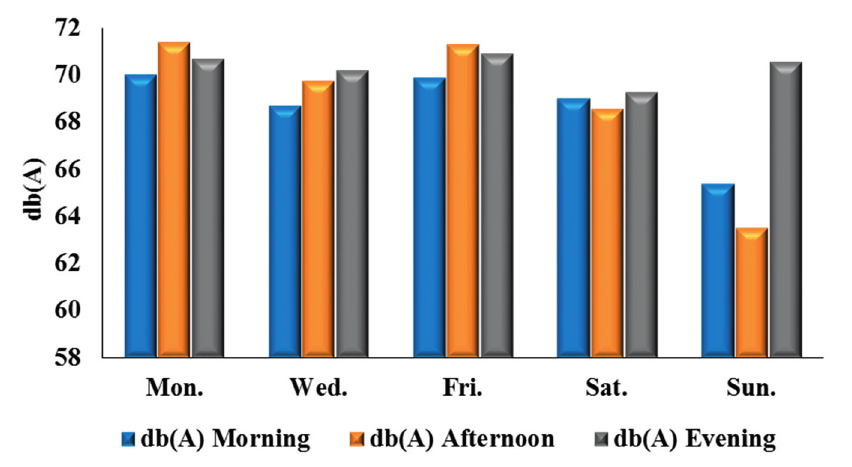
Figure 4. Daily average noise levels in